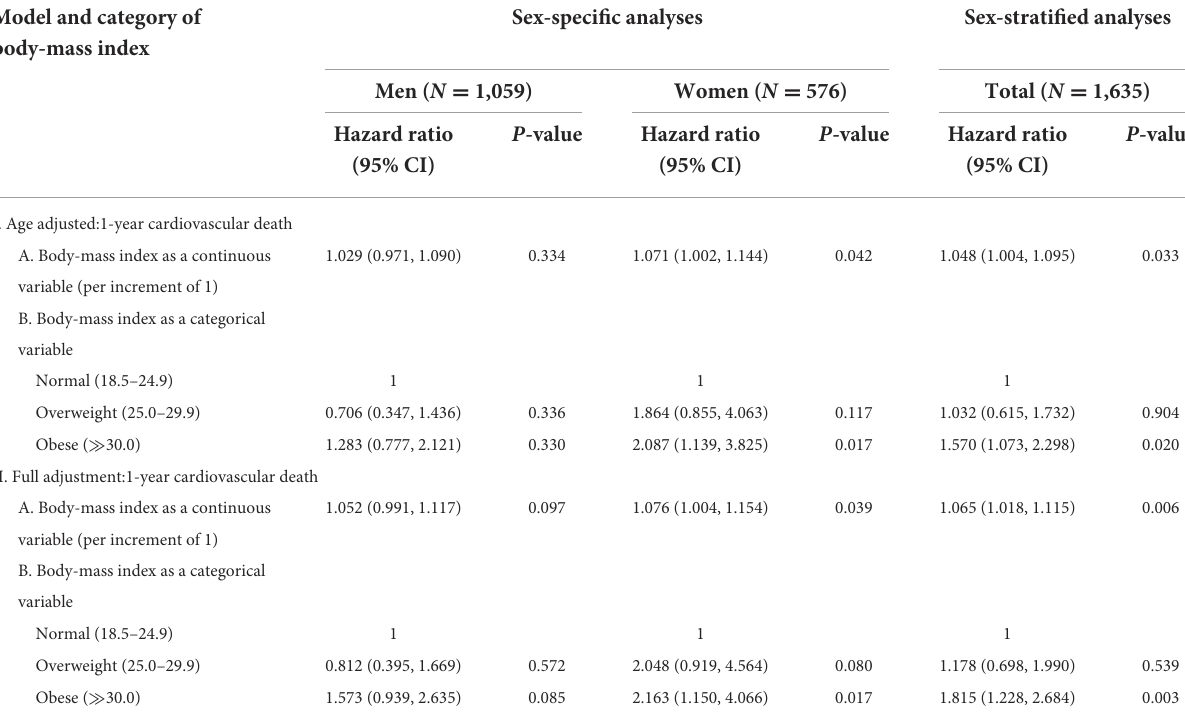
TABLE 3 Results of multivariable cox proportional-hazards models examining the relation of body-mass index to the risk of heart failure. Model and category